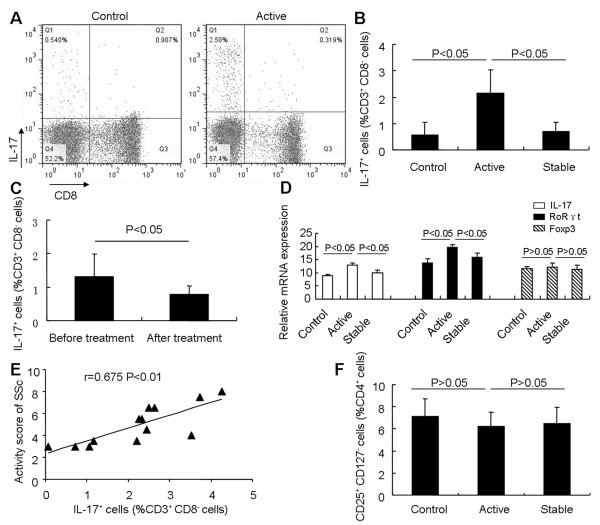
Expansion of Th17 cells in PBMCs of patients with active SSc. (A) Human PBMCs were labeled with antibody against lymphocytes (anti-CD3 and -CD8). IL-17-expressing cells were detected by intracellular cytokine staining assay, and the percentage of IL-17+ cells among CD3+CD8- T cells was determined with flow cytometry. (B) Results of flow-cytometric analysis of Th17 cells in patients with active SSc (n = 13), patients with stable SSc (n = 32), and controls (n = 24). (C) Longitudinal monitoring of Th17 cells in 10 patients. The percentage of Th17 cells was measured initially during active SSc and again after resolution after treatment. (D) Real-time RT-PCR analysis of IL-17, Foxp3, and RORγt mRNA expression in freshly isolated PBMCs of patients with active SSc (n = 13), patients with stable SSc (n = 32), and controls (n = 24). (E) Positive correlation between the proportion of Th17 cells and clinical severity in active SSc patients, scored by using the Valentini score (n = 13). r = 0.675, P < 0.01. (F) Results of flow cytometric analysis of CD4+CD25+CD127- Treg cells in patients with active SSc (n = 13), patients with stable SSc (n = 32), and controls (n = 24).